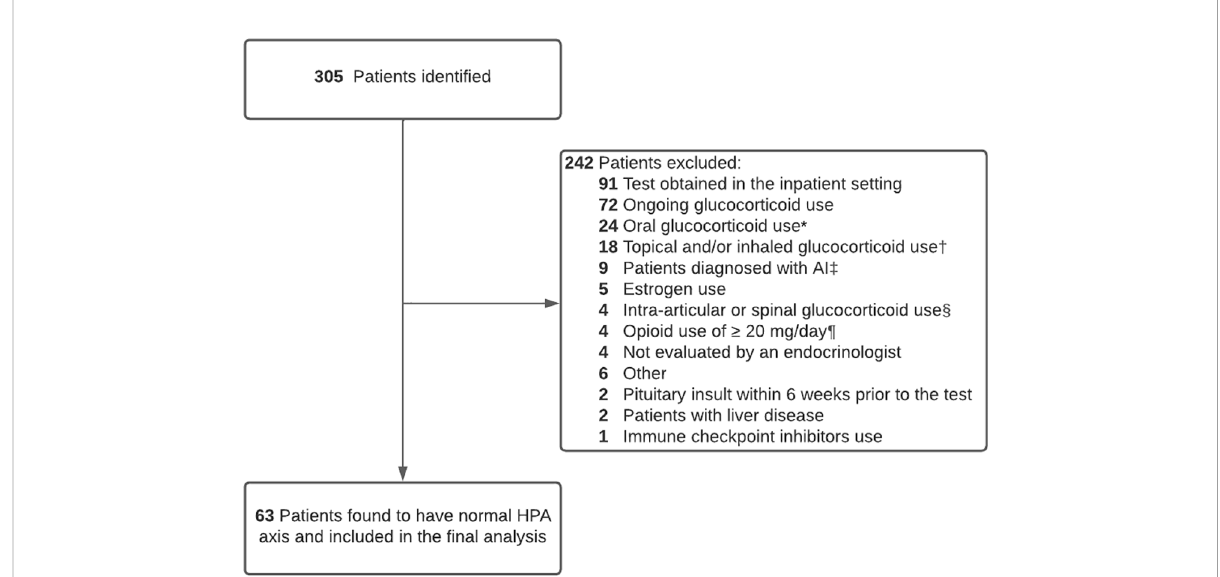
FIGURE 1 Study Flow Chart of 63 patients who were included in the fi nal analysis of the study. * Oral glucocorticoid use for more than a week within 6 months prior to the CST † Topical or inhaled glucocorticoid use for more than a week within 3 months prior to the CST ‡ Patients who were considered to have AI on initial evaluation by the treating endocrinologist. § Intra-articular or spinal glucocorticoid injection use within 3 months prior to the CST, or if the patient received more than 2 injections within 12 months prior to the CST¶ Opioid use at doses of morphine milligram equivalent (MME) ≥ 20 mg/day within 3 months prior to the